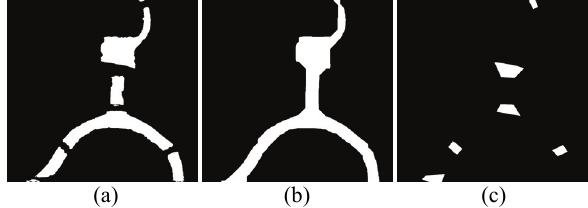
Figure 16. (a) initial river mask with false detected small cluster removed, (b) connected river mask by applying morphological closing, and (c) the final bridge mask by finding the convex hull of each region in the difference between (b) and (a). TomoSAR point cloud, and projected to the optical image. The projected bridge points are shown in Figure 17 where the color represents the amplitude of seasonal deformation. The upper